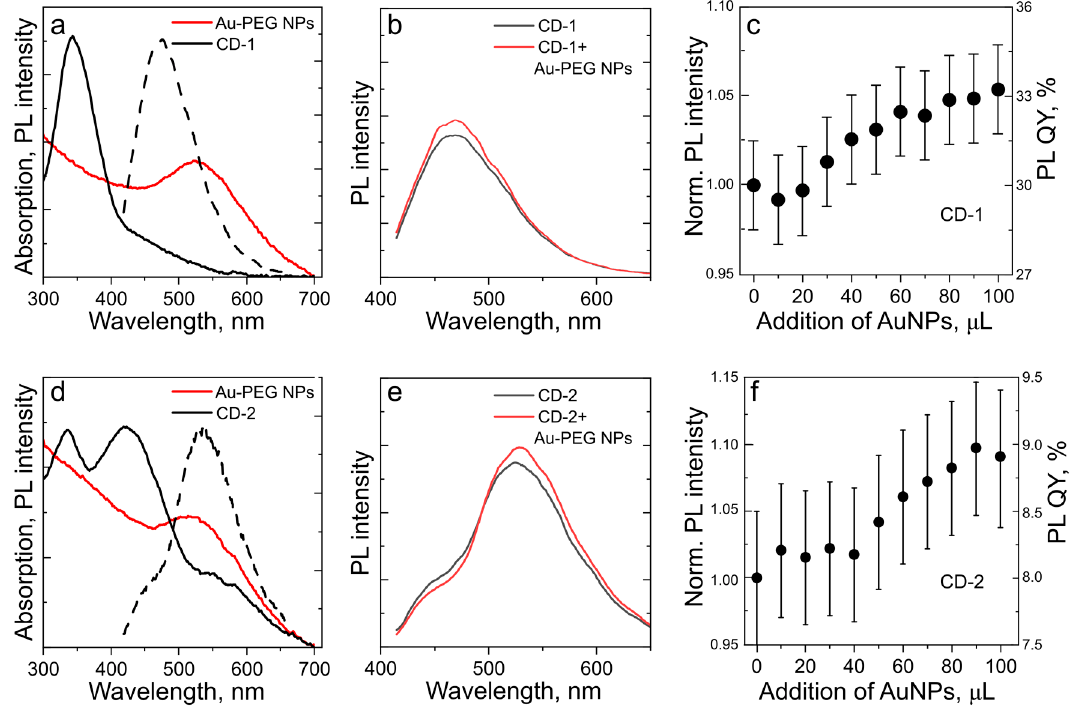
Figure 2. Dynamic interaction of Au-PEG NPs with CD-1 ( a – c ) and CD-2 ( d – f ): ( a , d ) overlapping of absorption (black line) and PL spectra excited at 405 nm (dashed black line) of CDs with absorption of Au-PEG NPs (red line); ( b , e ) PL spectra excited at 405 nm of CDs without (black line) and with Au-PEG NPs (red line); ( c , f ) change of the integrated PL intensity of CDs normalized to the intensity of pristine CDs (PL enhancement) and PL QY upon addition of increasing amount of Au-PEG